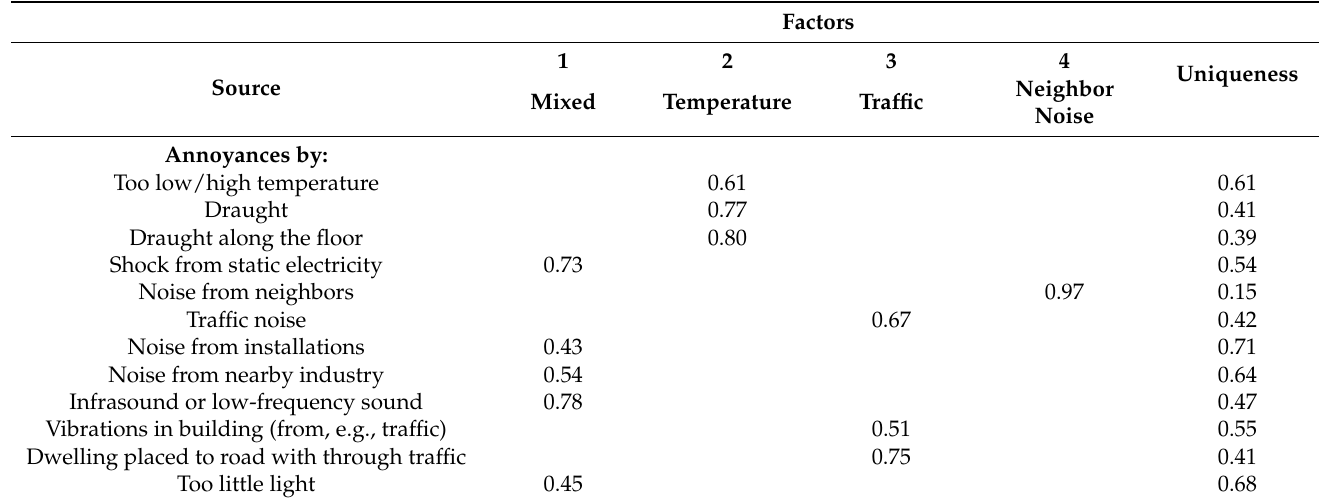
Table 3. Factor analysis of perceived annoyances in homes, and nearness to a road with through traffic, n = 16,349.